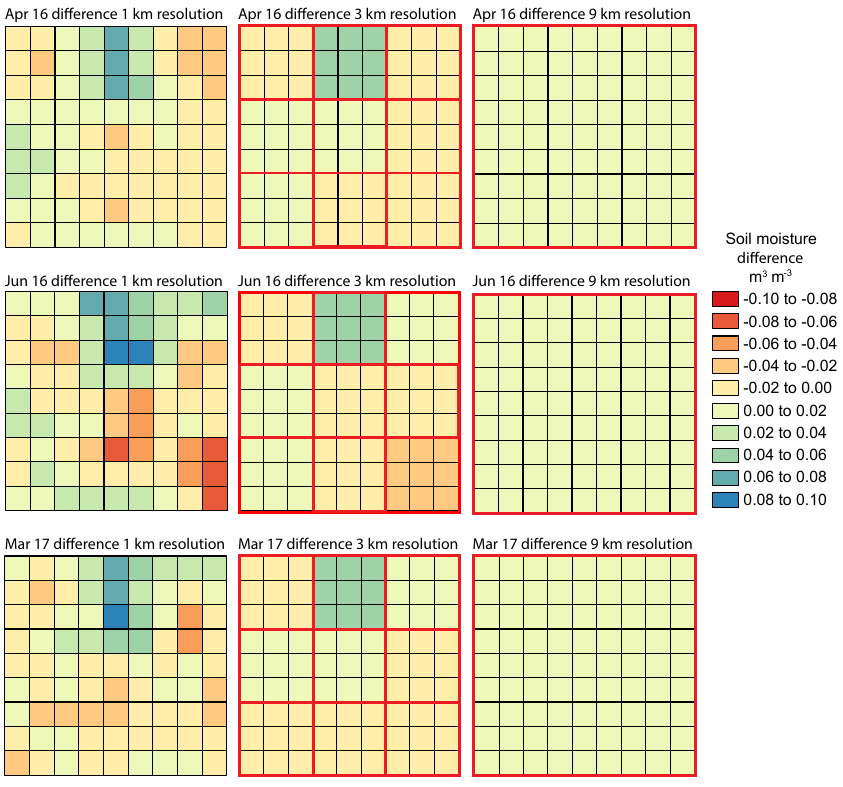
Figure 14. Difference in soil moisture estimates between the broad- and intensive-scale surveys for different resolutions on each of the three survey dates. Each cell represents a 1km × 1km region within the intensive survey